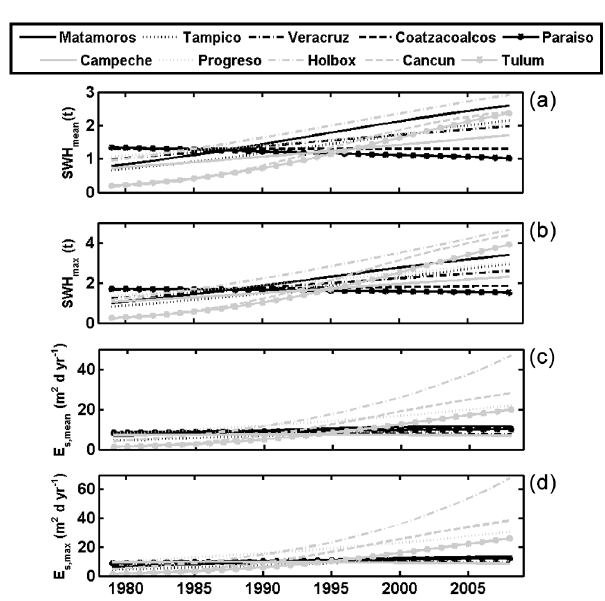
Figure 8. Estimated temporal evolution found in the TC-related storm time series of (a) SWH mean , (b) SWH max , (c) E s , mean and (d) E s , max per